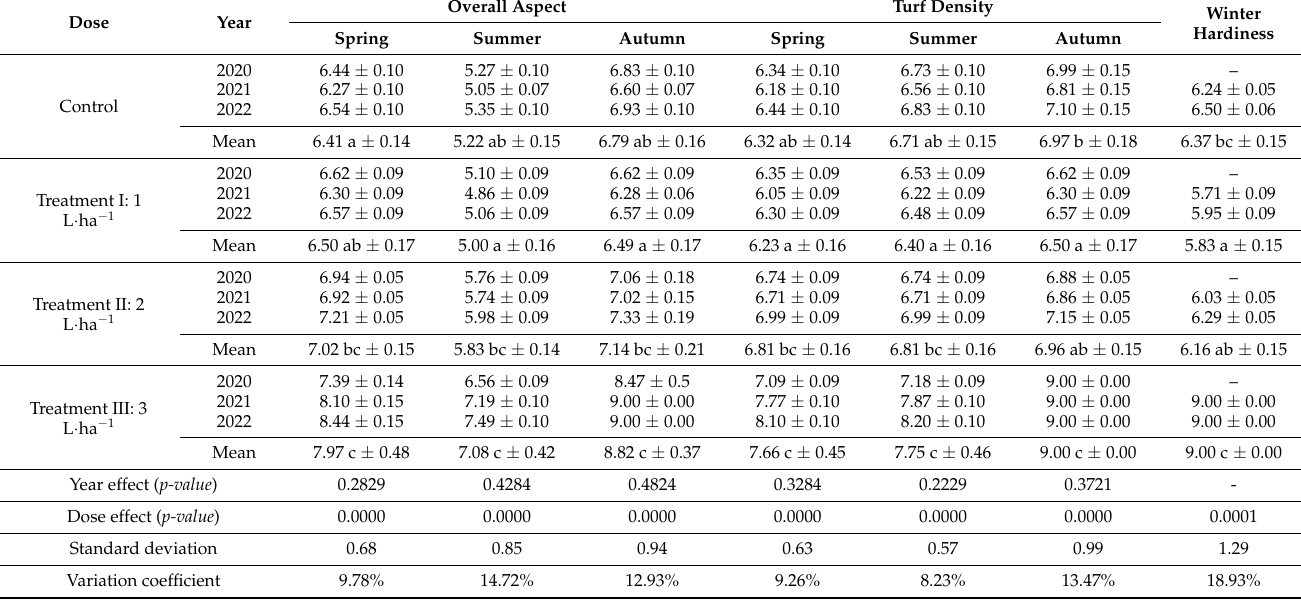
Table 5. Overall aspect, turf density, and winter hardiness depending on the year and dose of mineral-organic multi-component fertilizer